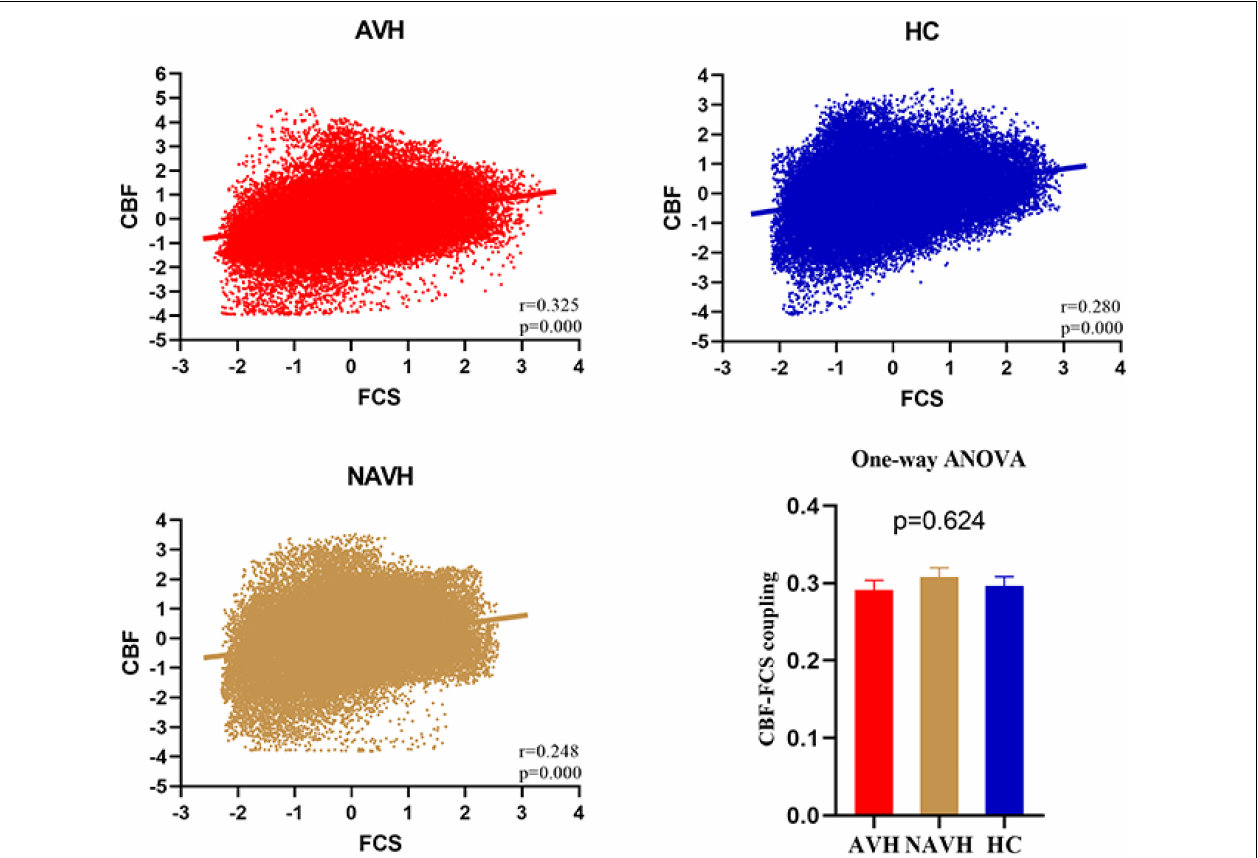
FIGURE 3 | Whole gray matter level cerebral blood flow–functional connectivity strength (CBF–FCS) coupling changes in schizophrenia. Scatter plots of the spatial correlations across voxels between CBF and FCS in an AVH (red), an NAVH patient (yellow), and an HC subject (blue), respectively. The mean whole gray matter level CBF–FCS coupling in AVH patients, NAVH patients, and HC. Although CBF is significantly correlated with FCS in both schizophrenia and control groups, there was no difference between the three groups. CBF, cerebral blood flow; FCS, functional connectivity strength; AVH, schizophrenia patients with AVHs; NAVH, schizophrenia patients without AVHs; HC, healthy control.